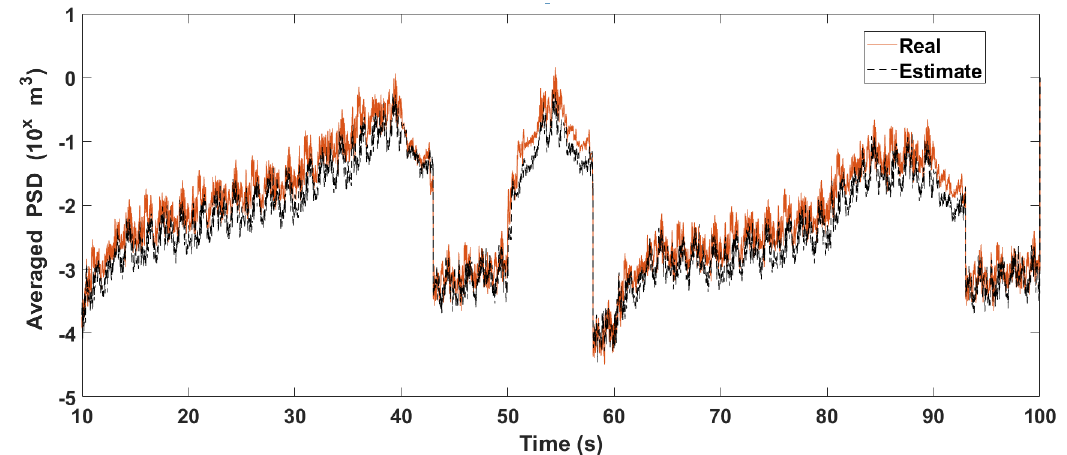
Figure 10. Road average PSD fitting.